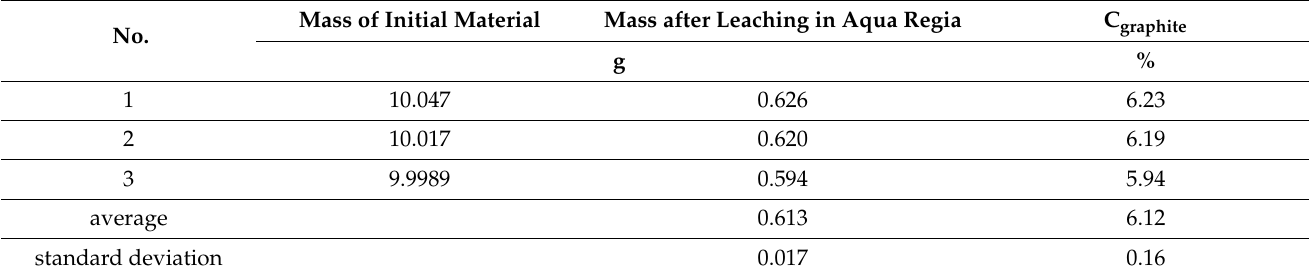
Table 1. Fraction of insoluble solid residue (C graphite ) in the initial material.